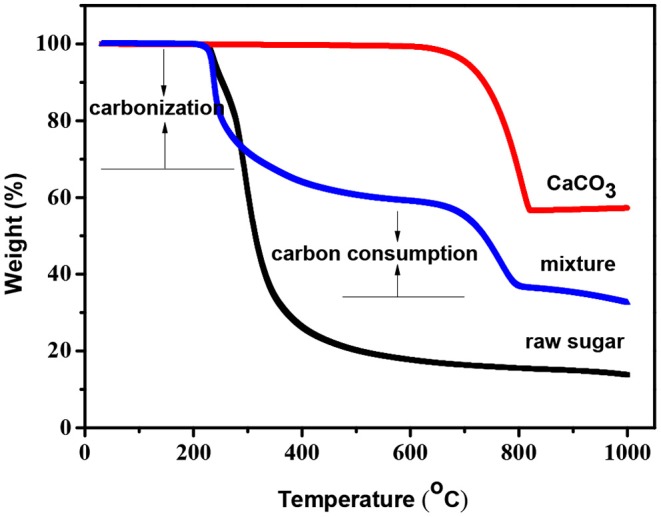
TG curves of raw sugar, nano-CaCO3, and raw sugar-CaCO3 mixture (ratio of raw sugar:CaCO3 = 5:5) under nitrogen flow.